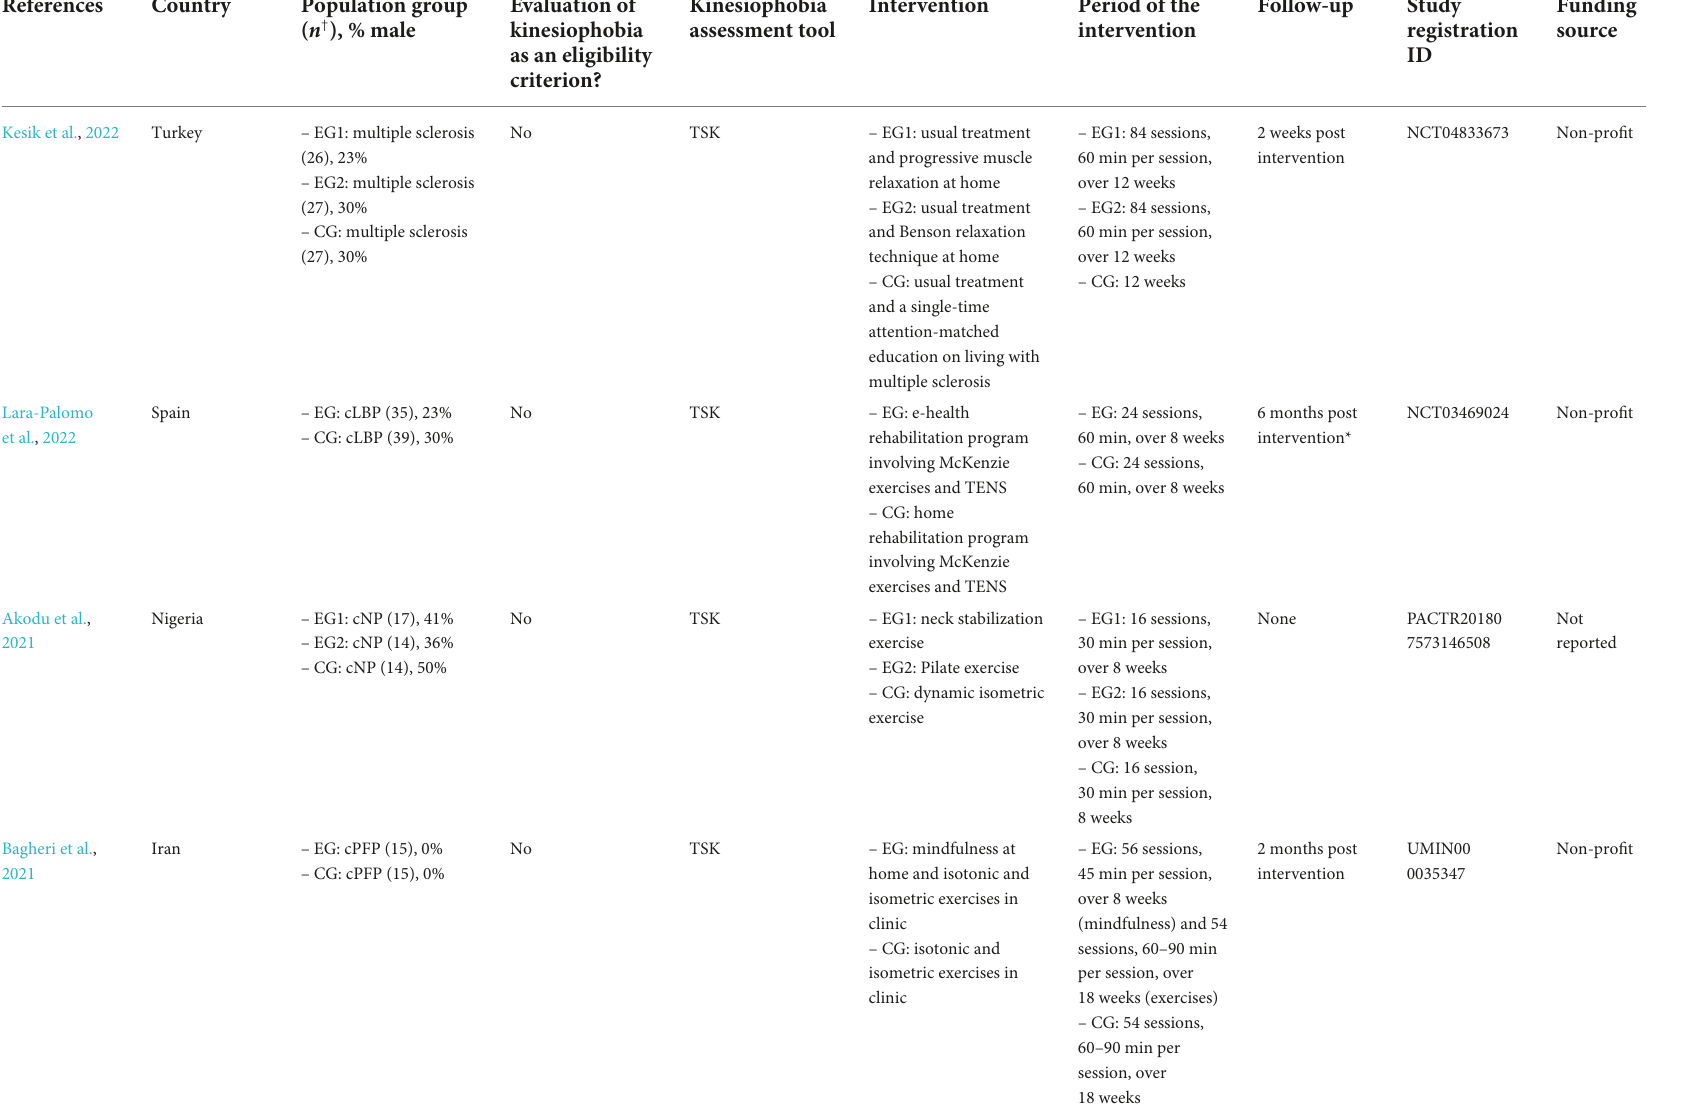
TABLE 1 Characteristics of the RCT included, shown in chronological